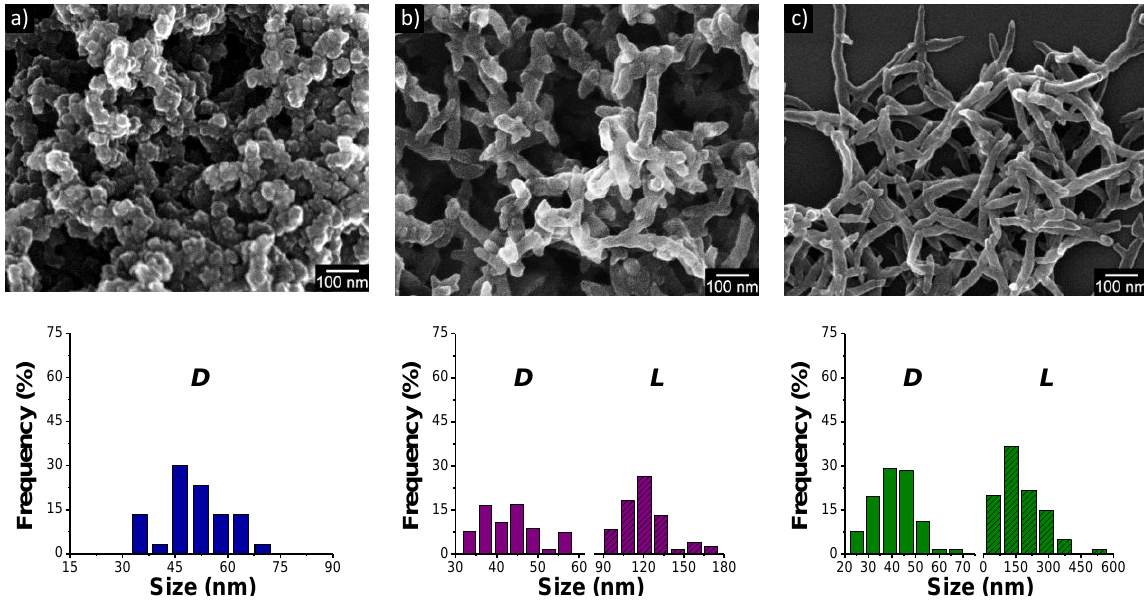
Figure 7. SEM images of polyaniline (PANI) nanostructures with different aspect ratios synthesized under the same stirring condition (200 rpm) and histograms showing their size distribution (D, diameter; L, length): ( a ) Nanospheres; ( b ) Nanorods; and ( c ) Nanofibers. With permission from [61]; Copyright 2012, American Chemical